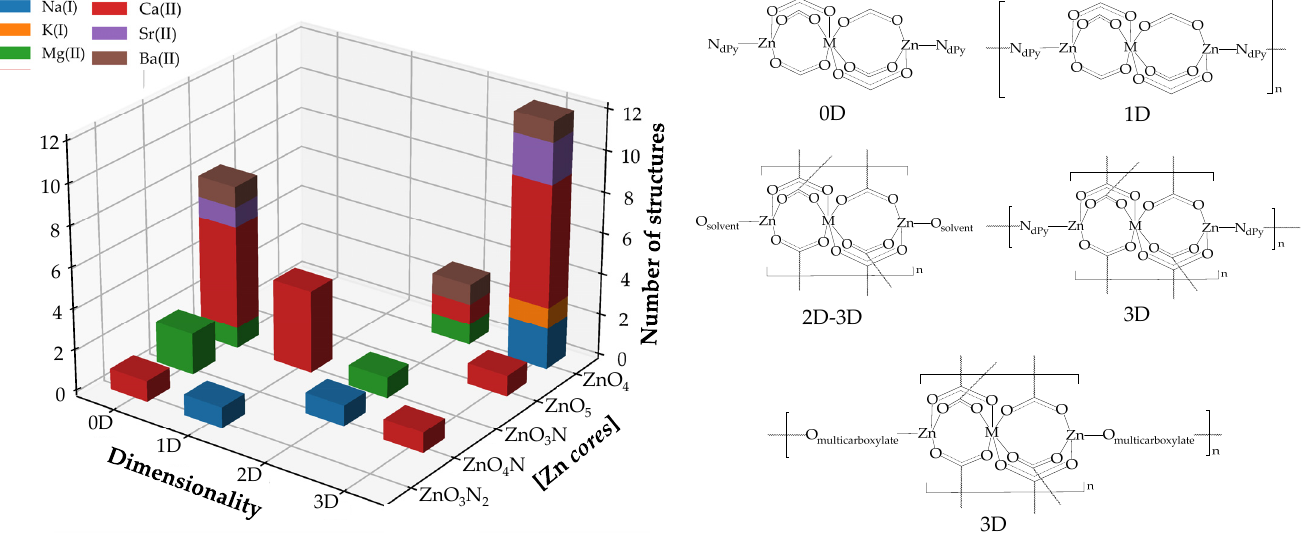
Figure 2. Results of the CSD study of [Zn 2 M] pinwheel SBUs (M = s-block metal ion) with a representation of the more abundant type of structures.